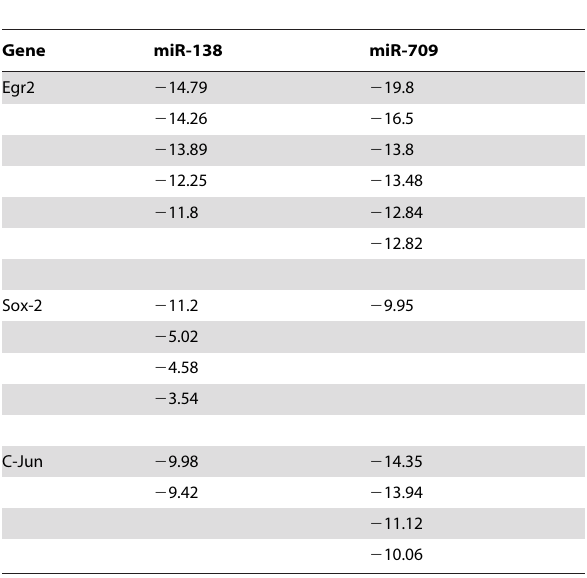
Table 1. STarMir analysis of accessibility of miRNA binding sites in targets ( SD G total,